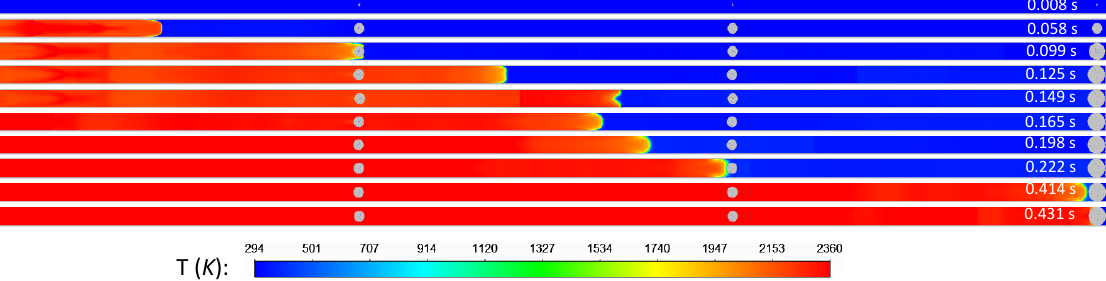
Figure 17. Flame propagation after explosion occurs for the scenario in which both Obstruction 1 and Obstruction 2 are half inflated and Obstruction 3 is fully inflated (with a 100% blockage).